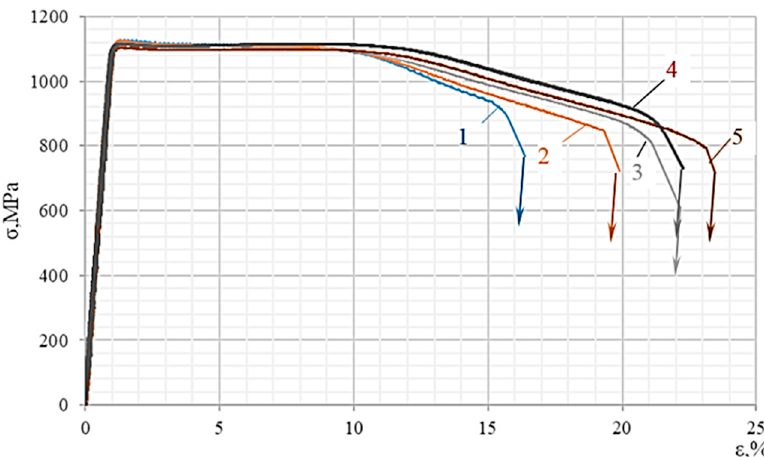
Figure 3. Typical stress strain diagrams for the VT23 alloy under static tensile testing after impulse introduction of energy under impact-oscillatory loading compared with the initial state: 1: initial state; 2: ε imp =1.5%; 3, ε imp =3.9%; 4: 3.8%; 5: 3.65%.